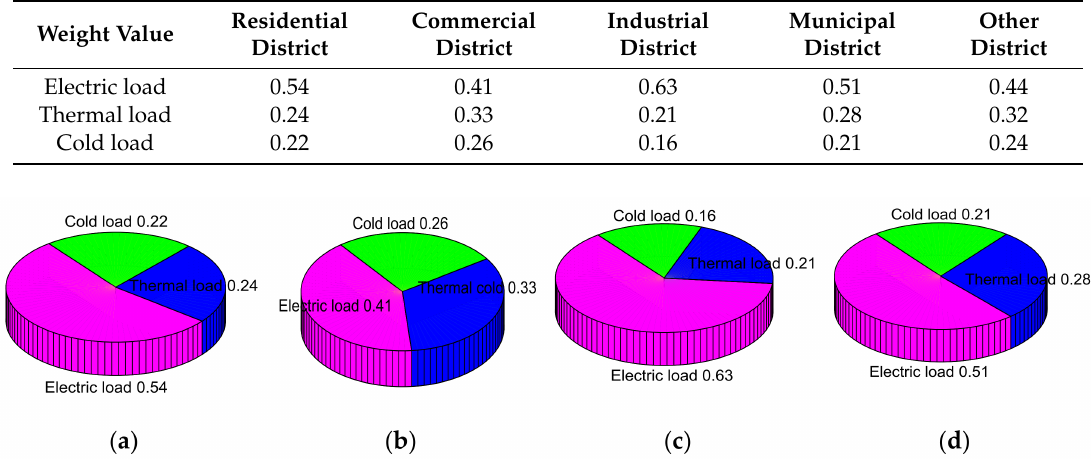
Figure 9. The weight values of the electric/thermal/cold loads in various typical functional districts. ( a ) Residential district; ( b ) commercial district; ( c ) industrial district; ( d ) municipal district.